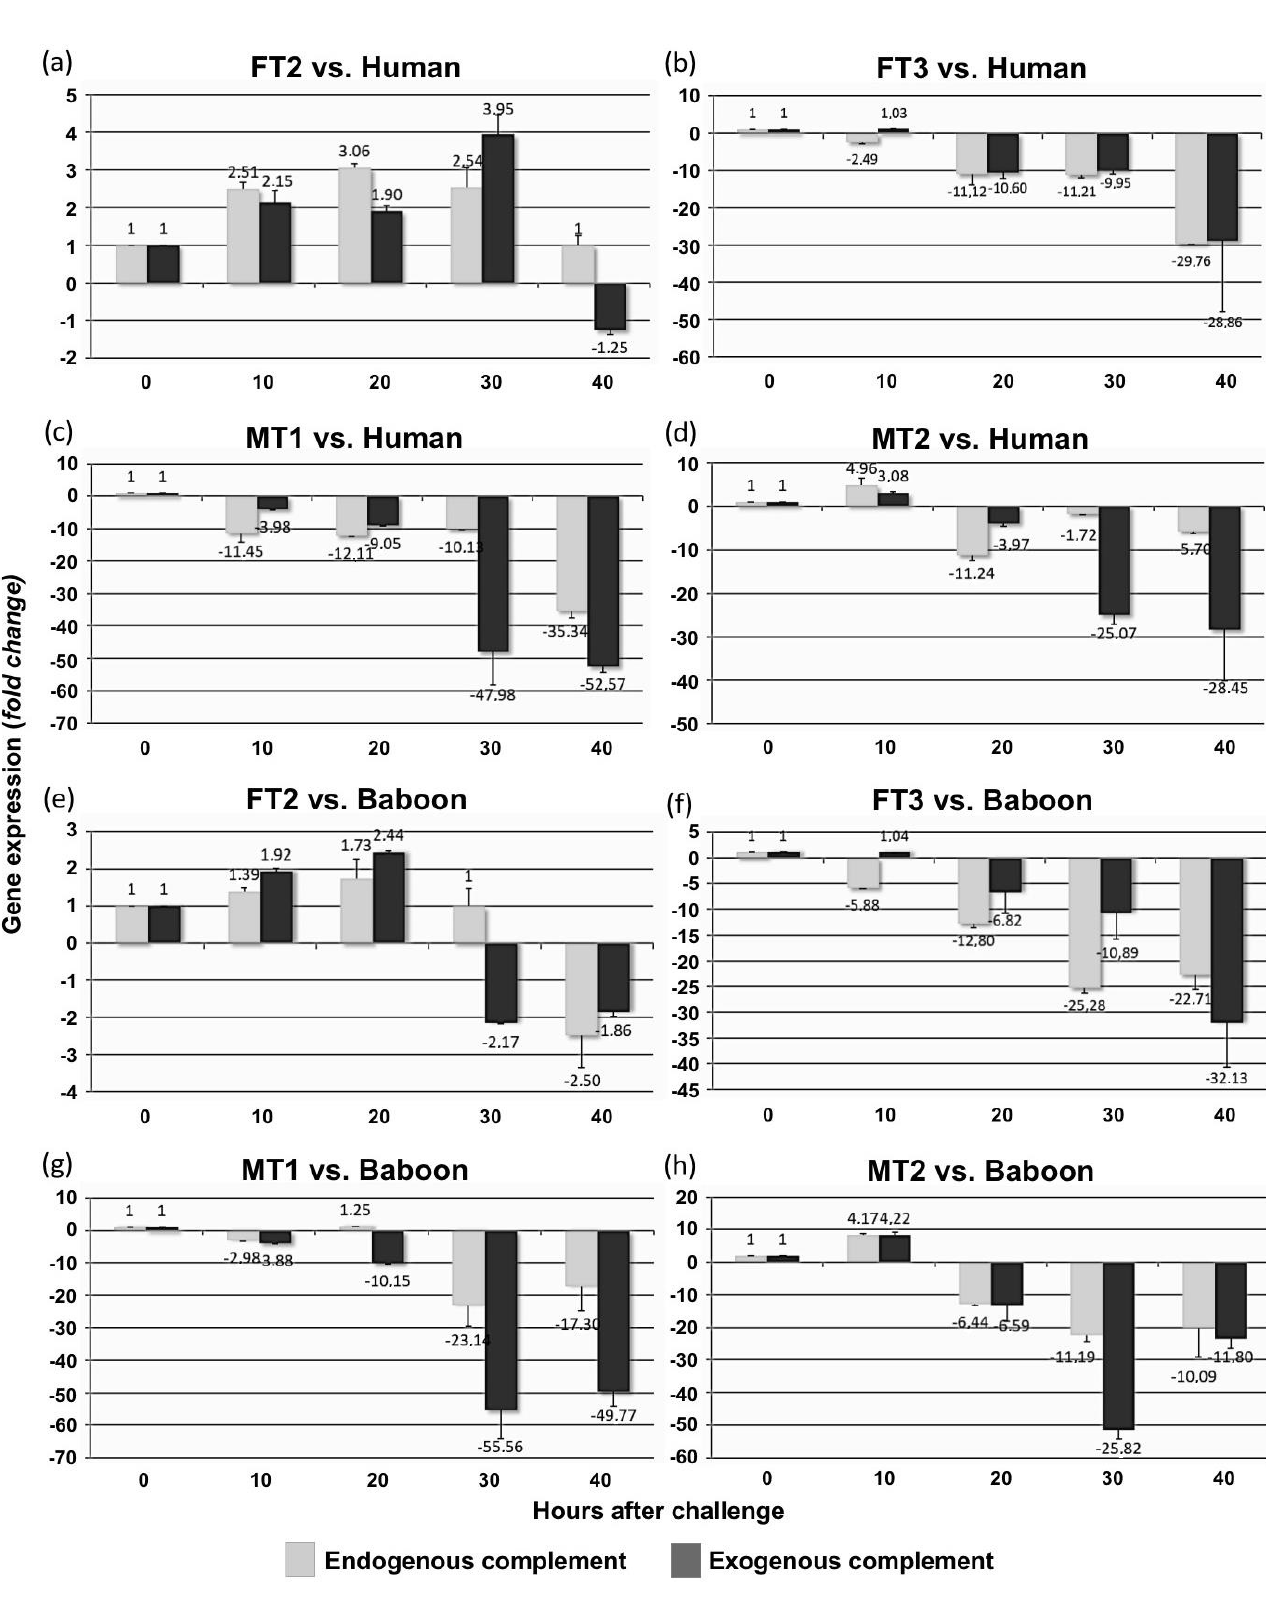
Figure 6. Resistance to serum-induced cytolysis is linked to hCD55 expression pattern. Normalized hCD55 gene expression at 10, 20, 30 and 40 h after challenge for each transgenic lineage challenged with serum with (blue bars) or without (green bars) rabbit complement addition. Left column ( a – d ) corresponds to samples challenged with human serum, while the right column ( e – h ) corresponds to samples challenged with baboon serum. Results are shown as mean ± standard error of the mean (SEM) of triplicate measurements.